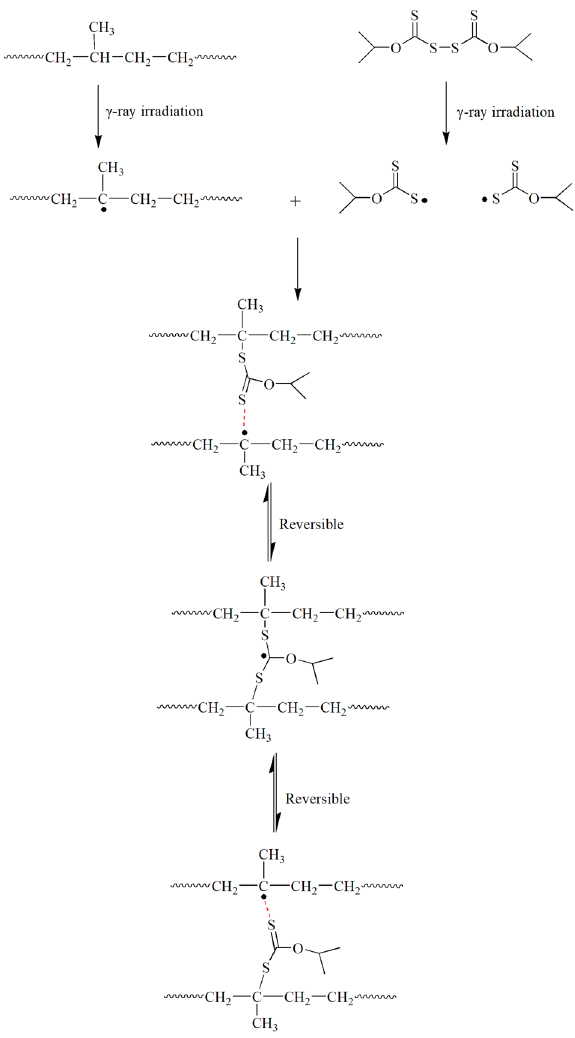
Fig. 13 Simpli fi ed reaction scheme for the reactions occurring in the EPDM/DIP systems under γ -ray irradiation. This Simpli fi ed reaction scheme can correspond to the process of the reversible control of radicals shown in Fig. 12.